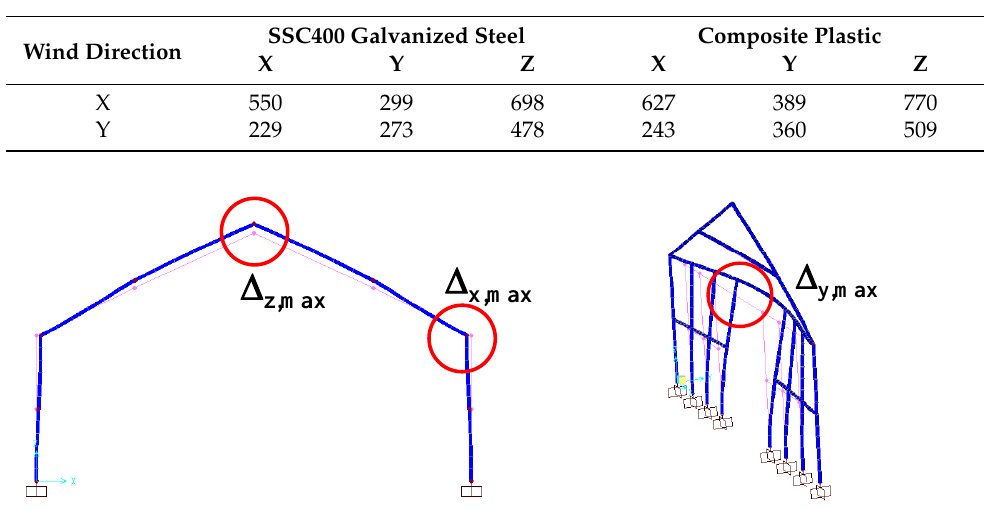
Figure 3. Locations of peak displacement response under the design wind load. Table 5. Comparison of peak internals under equivalent wind load (kN, m).